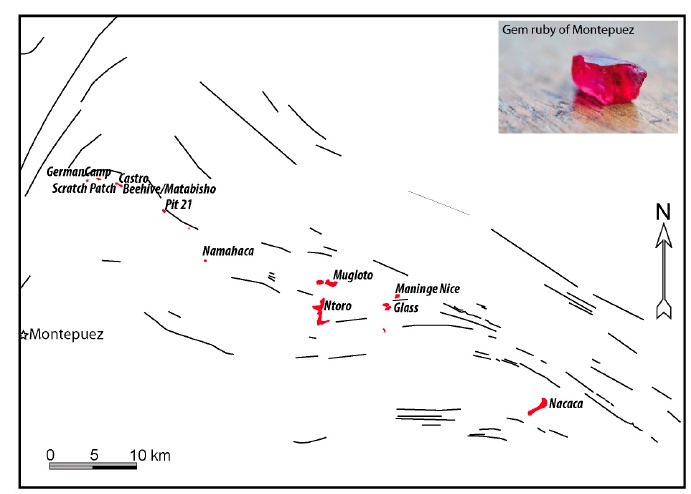
Figure 32. The Montepuez mining district with the different ruby mines of primary and mostly secondary deposits (drawn as red spots). The structural trends observed from both satellite imagery and field works are shown. The ruby mineralization defines a N110°E trending zone that extends for 40 km; modified from [25]. Crystal of ruby (size 1 cm long). Photo: Vincent Pardieu © GIA.